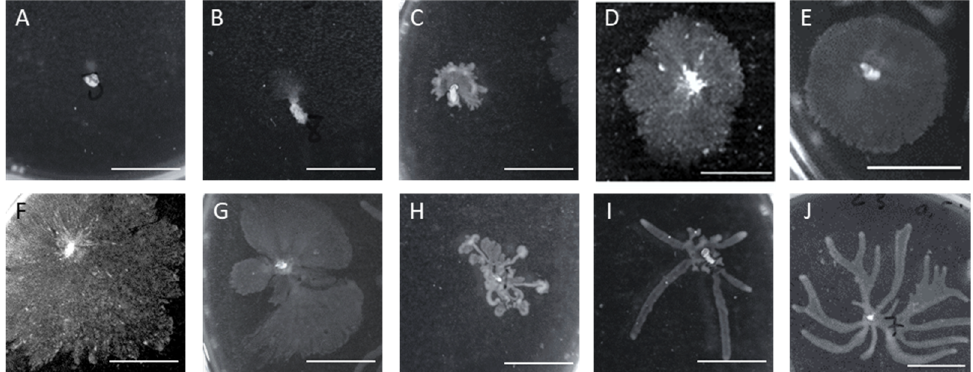
Figure 7. Different swarming motilities observed in surviving cells. ( A – J ) images acquired using Chemi XT4.